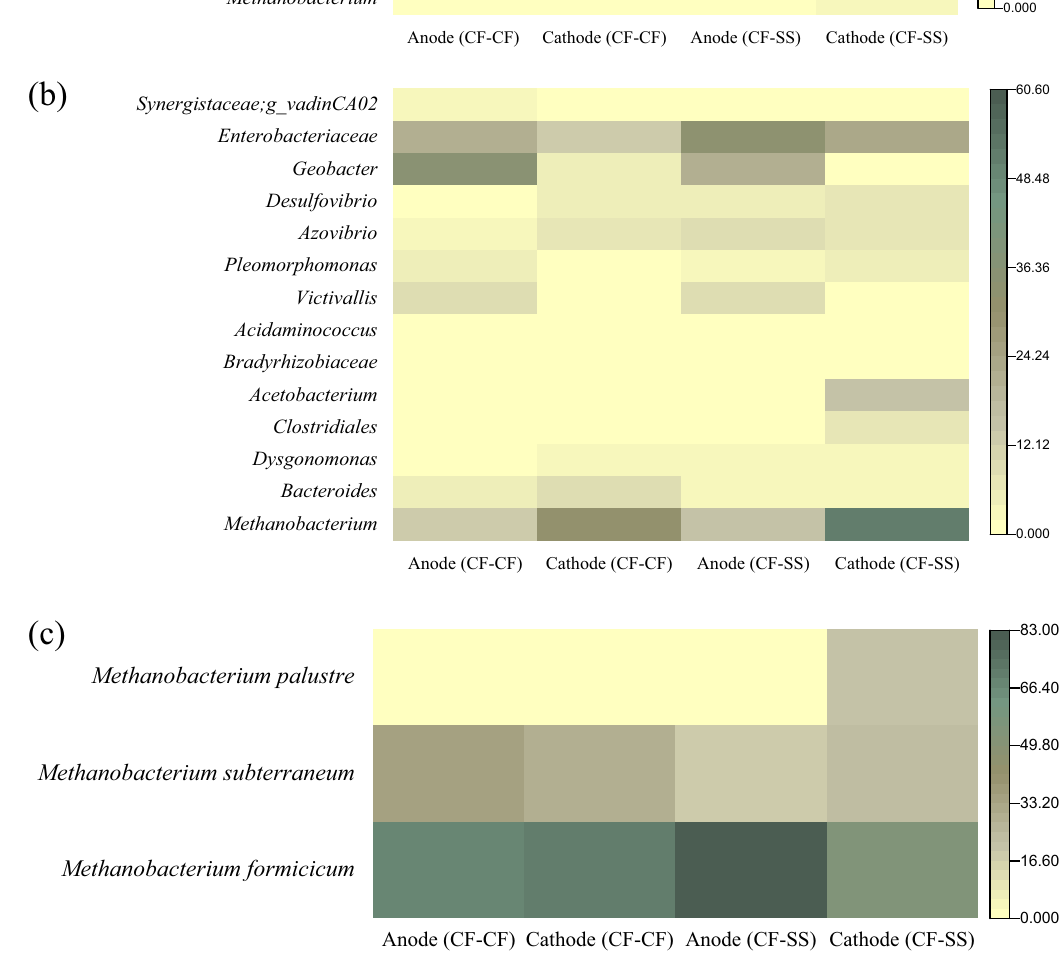
Figure 5. Relative abundance of microbial communities analyzed with bacterial primer ( a ), archaeal primer ( b ), and mcr A primer ( c ) at the genus